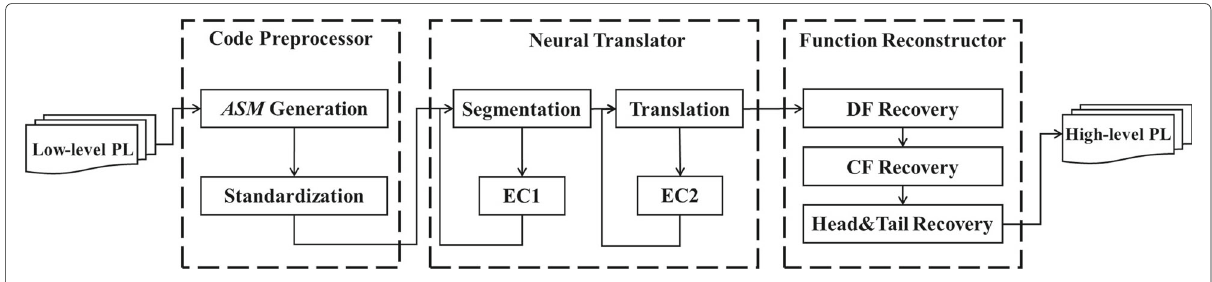
Fig. 1 An overview of Neutron